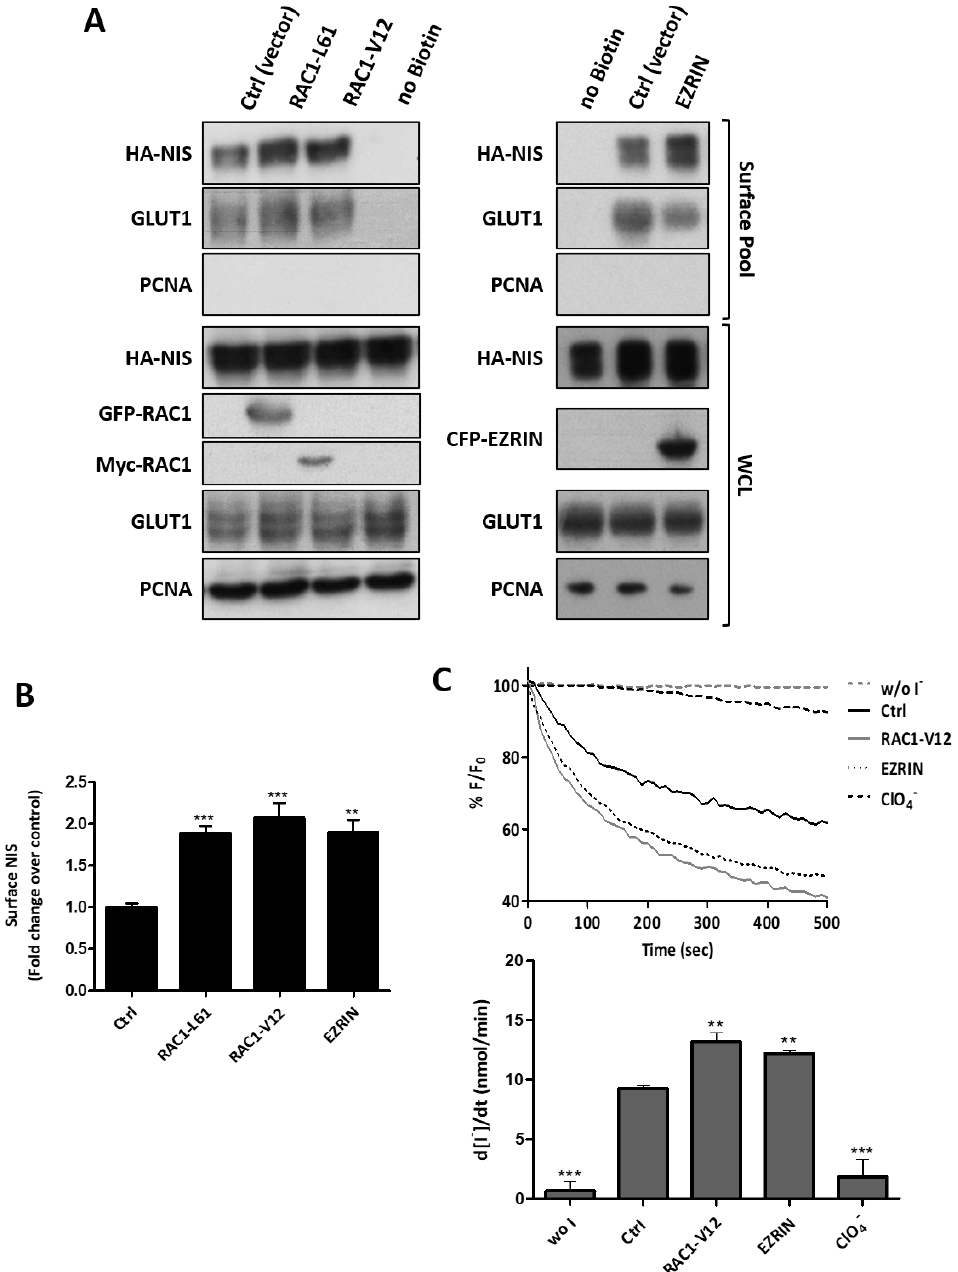
Figure 5. Upregulation of RAC1 and EZRIN increases the NIS residency at the PM. ( A ) HA-NIS-TPC1 cells were transiently transfected with either empty vector (Ctrl), GFP-RAC1-L61, MYC-RAC1-V12 or CFP-ERZIN constructs, and were analyzed by cell surface protein biotinylation. The surface fractions and the corresponding whole-cell lysates (WCL) were analyzed by WB, as indicated. PCNA detection served as the loading (WCL) and intracellular protein contamination control (Surface pool). GLUT-1 served as the positive loading control for the cell-surface protein extracts. ( B ) WB bands were quantified by densitometric analysis using ImageJ software. The plotted values are the means ± SEM of five independent assays. A one-way ANOVA analysis detected significant differences between the treatments (F = 17.82; p < 0.001). Post-hoc Dunnett’s tests were used to identify significant variations relative to the control (Ctrl) conditions (** p ≤ 0.01; *** p ≤ 0.001). ( C ) HA-NIS-TPC1 cells stably co-expressing the HS-YFP iodide sensor were transfected with either empty vector (Ctrl), MYC-RAC1-V12 or CFP-ERZIN, or were treated or not with 50 mM of ClO 4 − for 10 min, and YFP fluorescence was recorded continuously (as described in the legend to Figure 1). The data are the means ± SEM of three independent assays. One-way ANOVA analysis detected significant differences between the treatments (F = 59.51 and p < 0.001). Post-hoc Dunnett’s tests were used to identify significant variations relative to the control (Ctrl) conditions (** p ≤ 0.01; *** p ≤